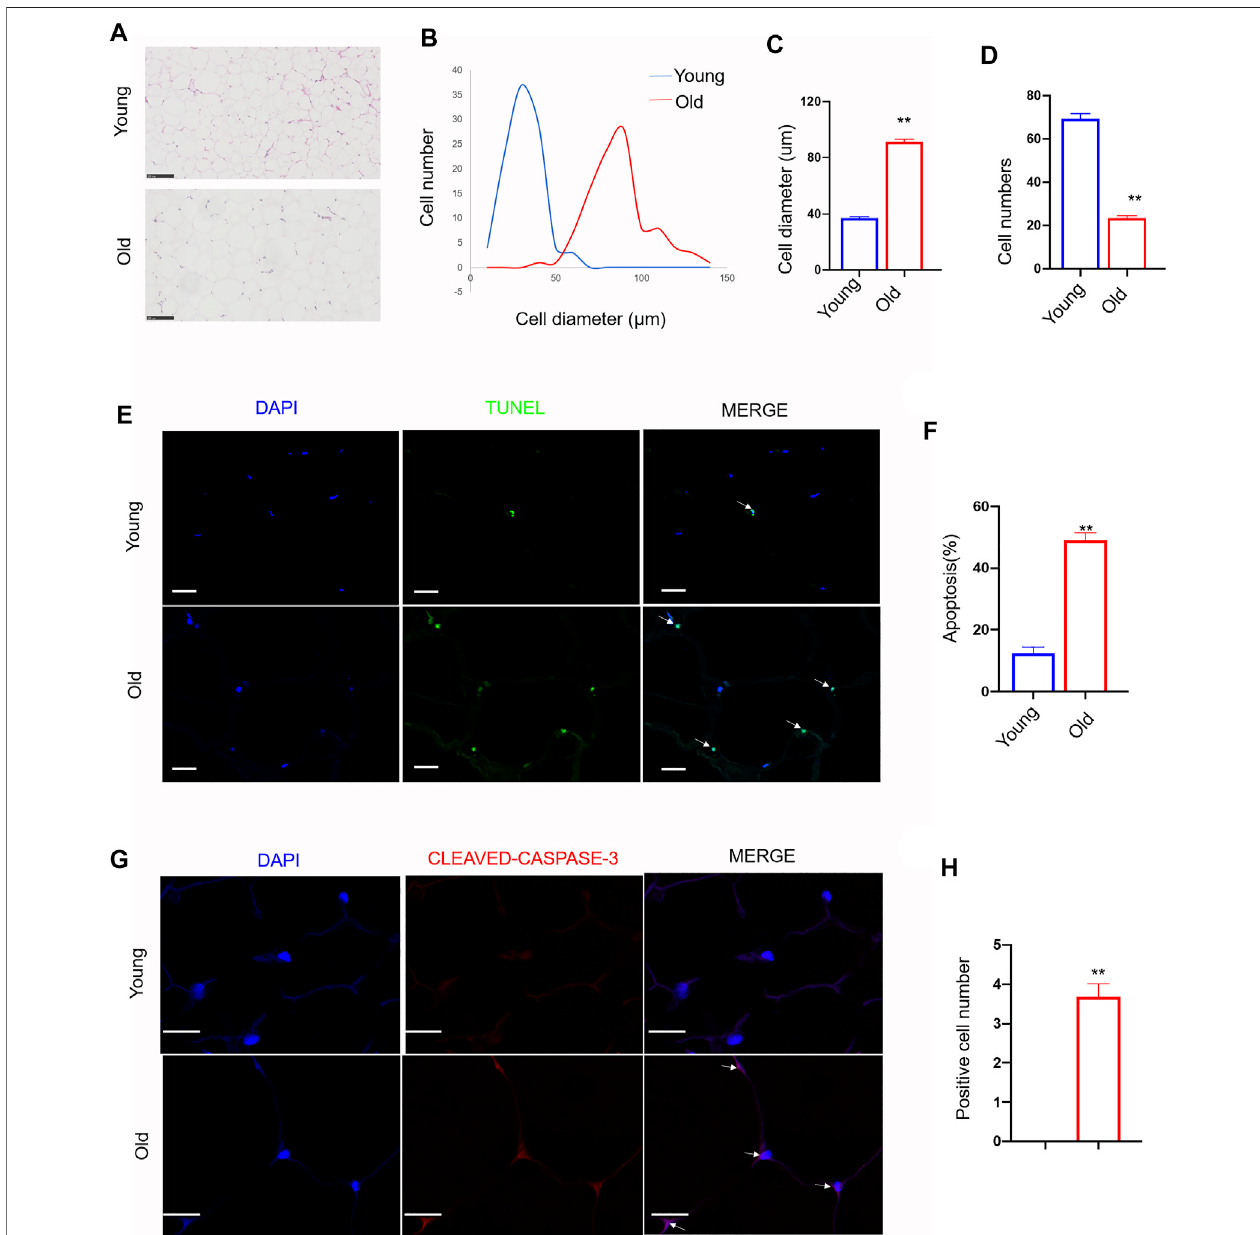
FIGURE 1 | Effect of aging on cell morphology, diameter, number and apoptosis in rat subcutaneous adipose tissue. Subcutaneous adipose tissue was isolated from young and old rats. (A) Representative images (200x) of Hematoxylin and eosin staining (H and E) in adipose tissue sections from young group and old group rat. scalebars:100 µm. (B – D) .Quanti fi cationofdiameterandnumberofadipocytesinsection. (E) Representativeimmuno fl uorescencestainingofTUNEL(green)andDAPI (blue) of the adipose tissue sections (n (cid:1) 3). Scale bars: 20 µm. (F) Quanti fi cation of apoptosis rate in adipose tissue sections. (G) Representative immuno fl uorescence staining of cleaved-caspase-3 (red) and DAPI (blue) of the adipose tissue sections (n (cid:1) 3). Scale bars: 20 µm. (H) Quanti fi cation of positive cell number of cleaved-caspase-3 in sections. The data are represented as mean ± SEM (n (cid:1) 100 cells per group). ** p < 0.01, vs young group (Student ’ s t test).